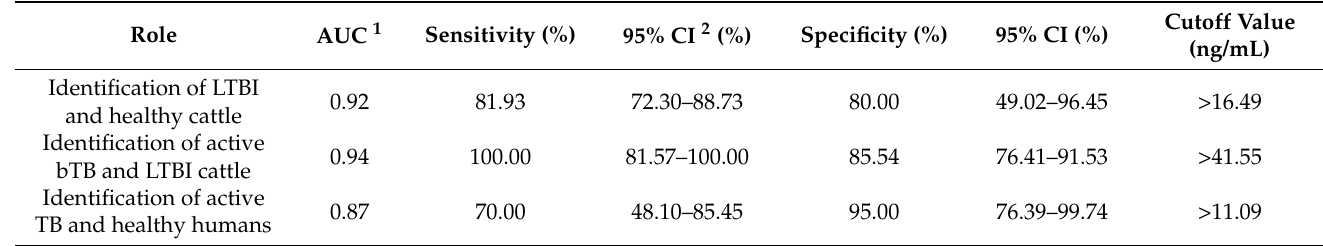
Table 1. Determination of the cutoff values for bTB and TB